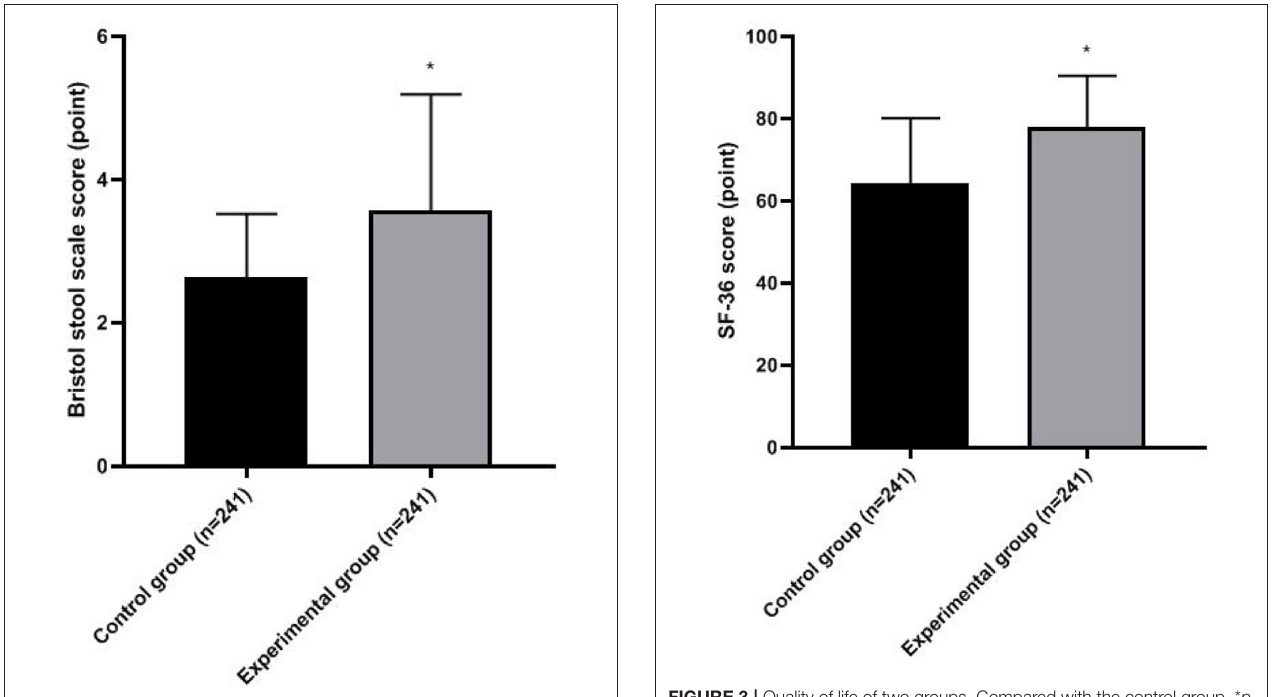
FIGURE 2 | Stool traits of two groups. Compared with the control group, * p < 0.05.